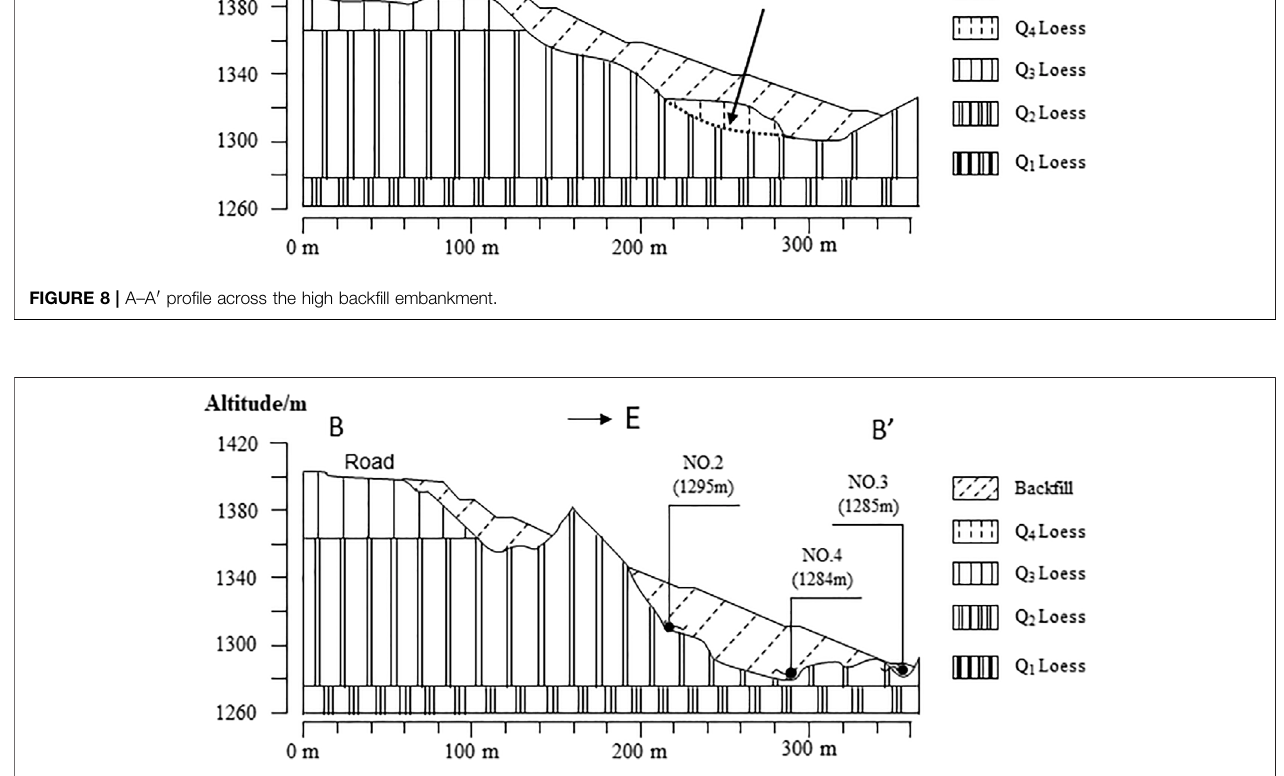
FIGURE 9 | B – B ′ pro fi le across the high back fi ll